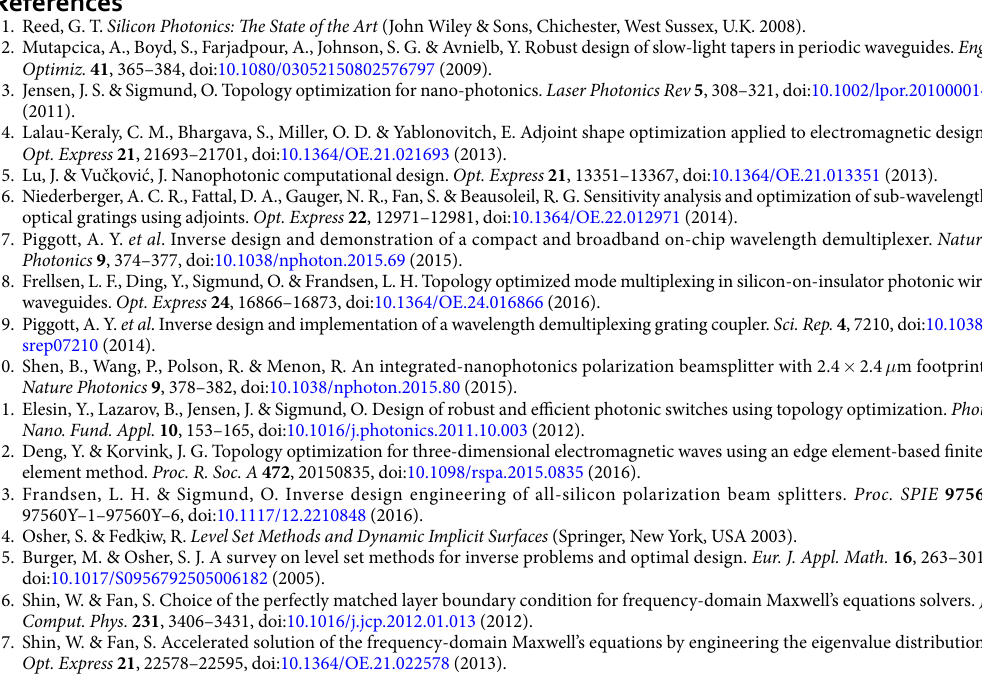
The simulated and measured transmission spectra of the device are plotted in Fig. 6. The simulations and measurements match reasonably well, although the measured devices have slightly higher losses and exhibit a spectral shift with respect to simulations. The device performance is highly consistent across all 4 measured devices, indicating that they are robust to fabrication error. The spectral shifts are likely due to slight over-etching or under-etching errors, as indicated by simulations we present in the supplementary information. The two key criteria for a power splitter are low insertion loss, and excellent power uniformity. The power uni- formity is defined as the ratio between the maximum and minimum output powers. Averaged over the designed wavelength range of 1400–1700 nm, our 1 × 3 splitter has a measured insertion loss of 0.642 ± 0.057 dB, and a power uniformity of 0.641 ± 0.054 dB. Here, the uncertainty refers to the variability between different measured devices.